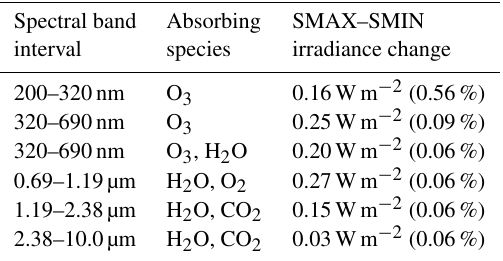
Table 1. Yearly mean irradiance change between the years 1981 and 1986 ( (cid:49) TSI = 1 . 06Wm − 2 ) for each of the UM-UKCA shortwave heating